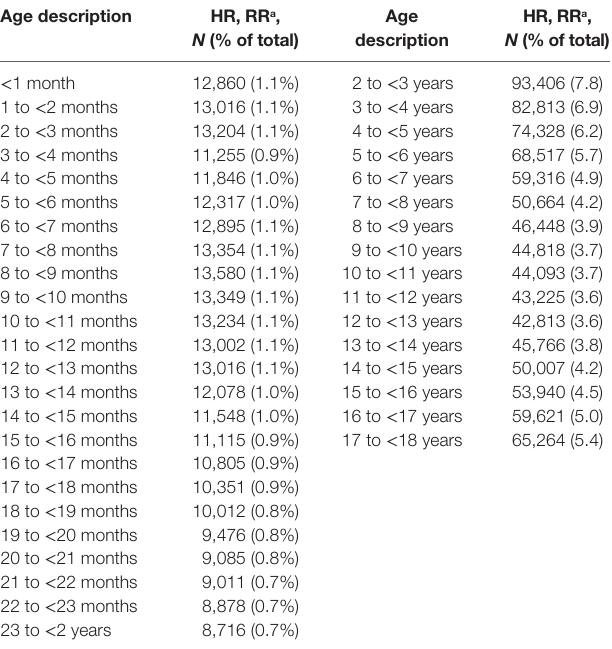
TaBle 1 | Number of contributing encounters by patient age